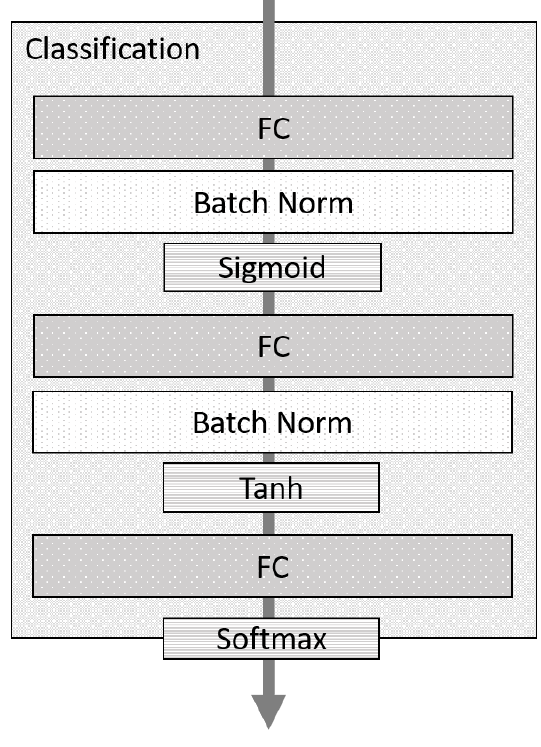
Figure 3. Classification